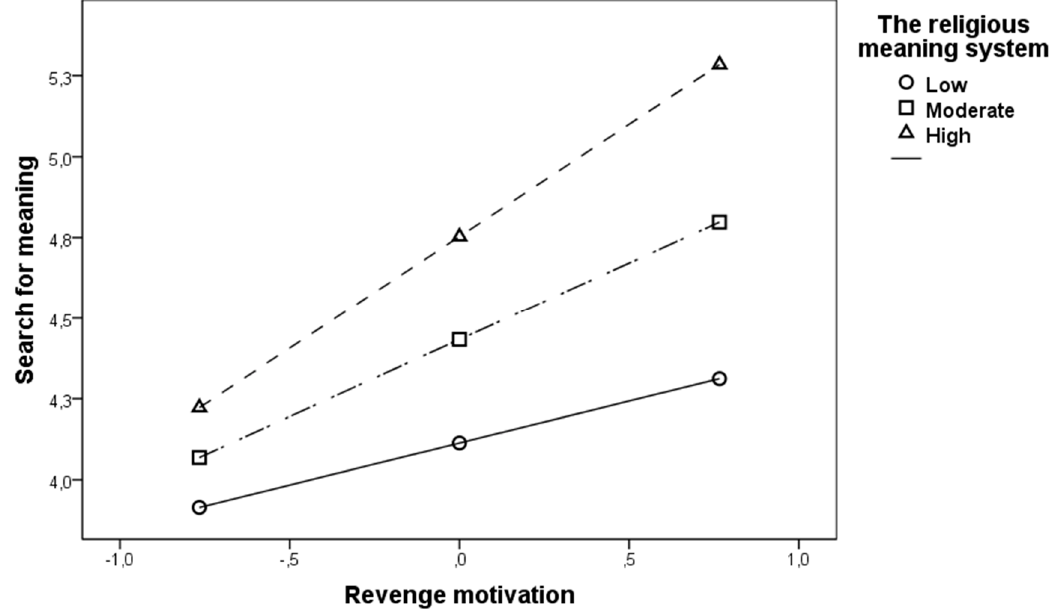
Figure 5. A visual representation of the moderation of the effect of revenge motivation on the search for meaning at low ( − 1SD), moderate (M), and high (+1SD) levels of the religious meaning system.